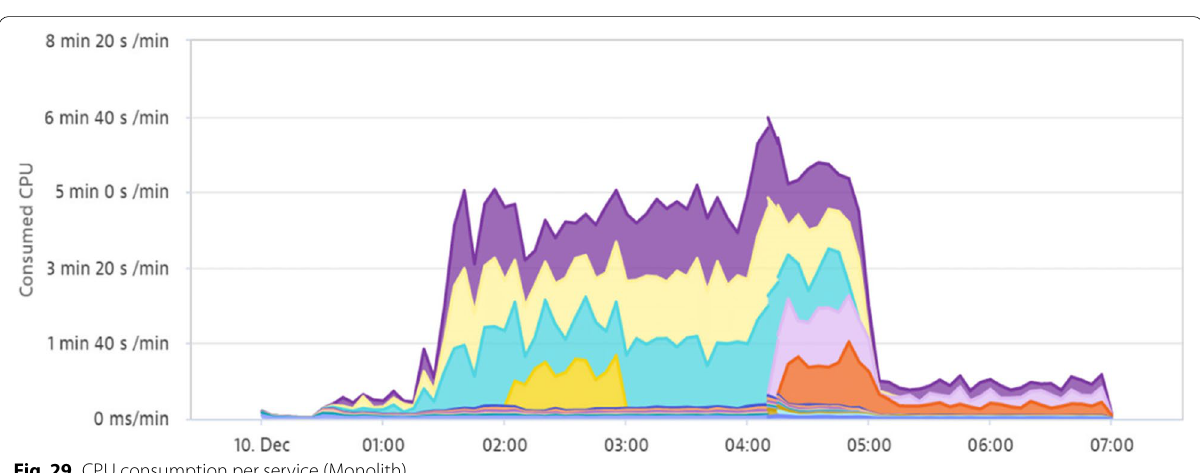
Fig. 29 CPU consumption per service